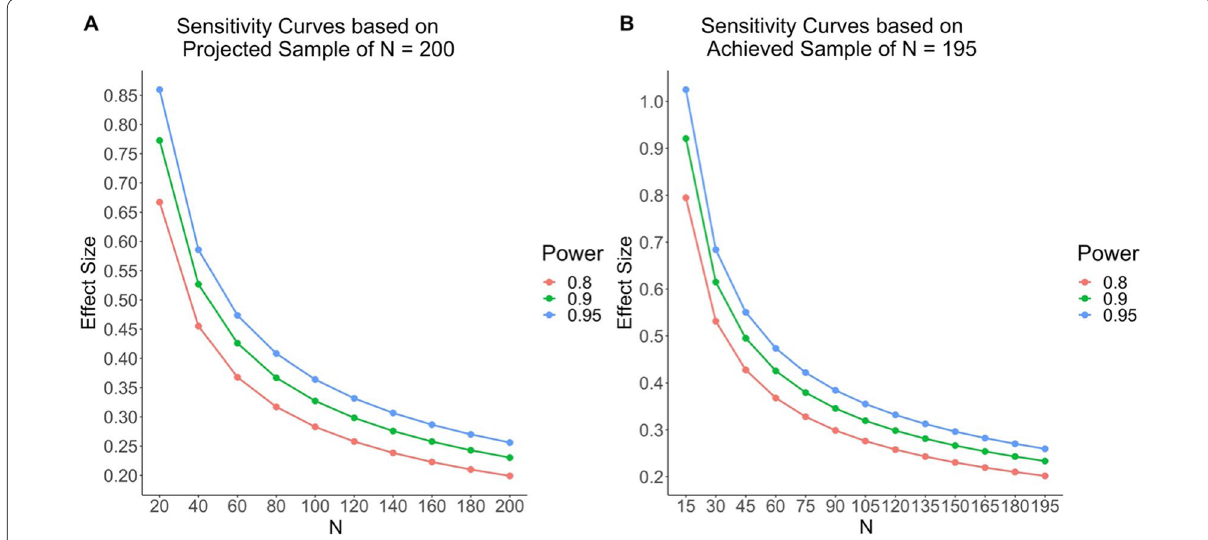
Fig. 1 Sensitivity curves based on projected (Panel A) and achieved (Panel B) sample sizes. Effect sizes are Cohen’s